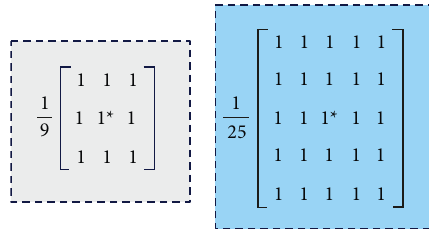
Figure 5: 3 × 3 and 5 × 5 templates.